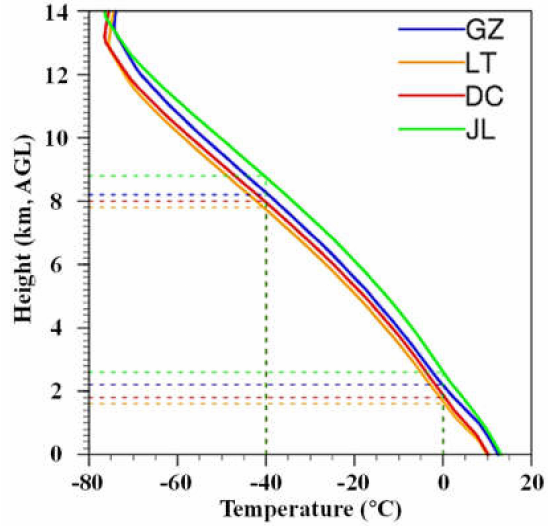
Figure 5. The vertical temperature gradient changes from ERA5 at four